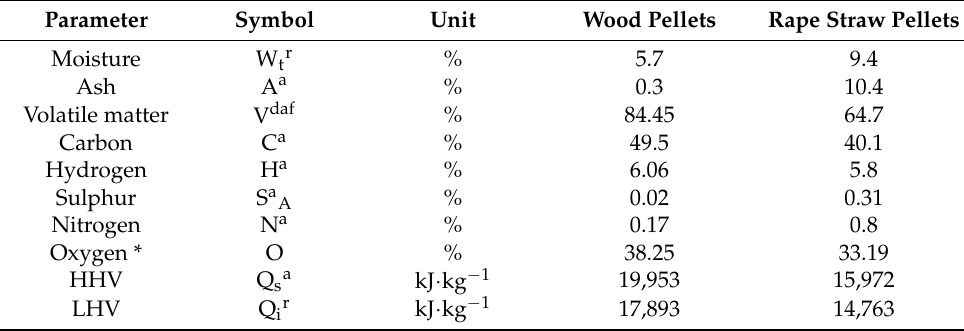
Table 1. Physicochemical properties of wood pellets and rape straw pellets.